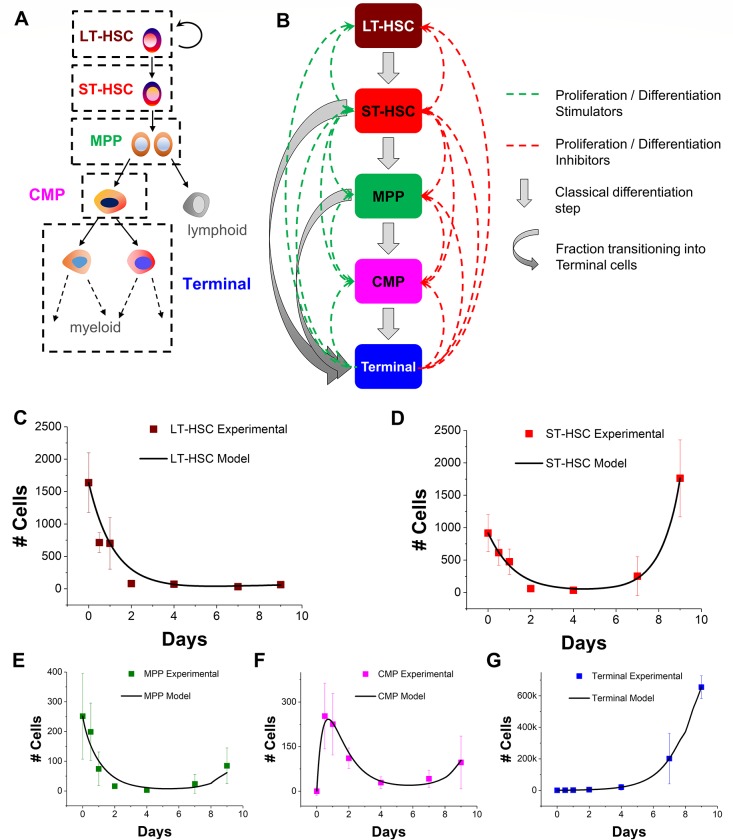
A five state model framework for HSC lineage specification.(A) A schematic of the classical HSC differentiation hierarchy where long-term progenitors (LT-HSC) differentiate into short-term (ST-HSC) progenitors, then multipotent (MPP), then common myeloid progenitors (CMP) before maturing into fully developed myeloid cells (Terminal). (B) A 5-state computational model featuring the LT-HSC, ST-HSC, MPP, CMP, and Terminal cell types. Culture dynamics may be influenced via feedback from cell-secreted biomolecules that stimulate and/or inhibit the proliferation and differentiation rates of each cell type. Additionally, a fraction of ST-HSCs and MPPs would be available to transition directly into Terminal cells without going through CMP differentiation (‘jump’). (C-G) The model simulation is able to capture the dynamics and scale of the experimental data for all 5 cell profiles (C: LT-HSC; D: ST-HSC; E: MPP; F: CMP; G: Terminal) over a 9 day period. Error bars represent standard deviation.